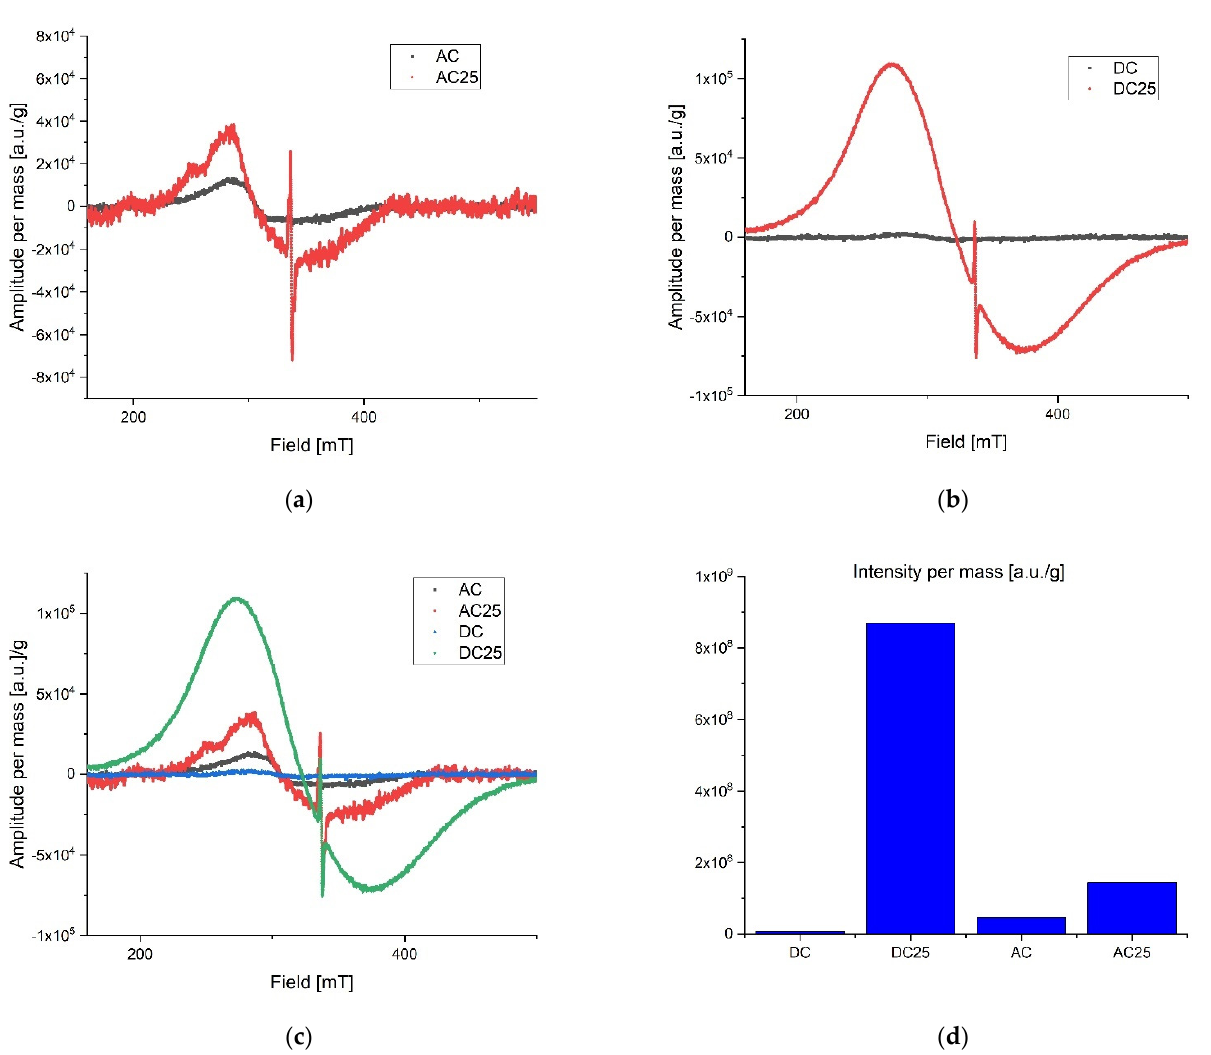
Figure 5. Extended range EPR spectra: ( a ) overlap AC and AC25; ( b ) overlap DC and DC25; ( c ) overlap AC, AC25, DC, DC25; ( d ) intensity proportional to the number of spins in arbitrary units per 1g mass.